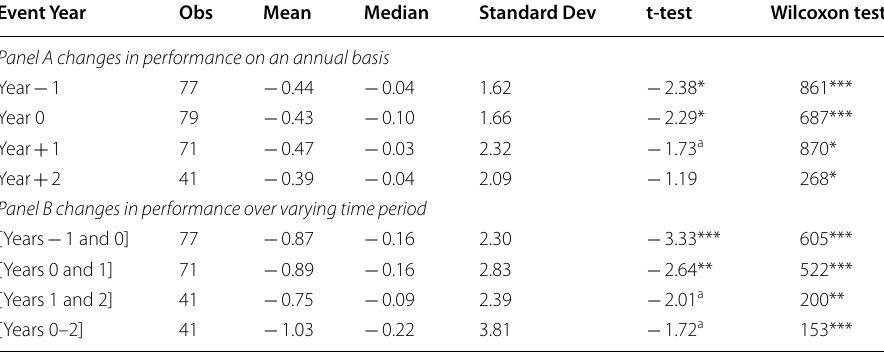
Table 10 Control adjusted percentage changes in Sales